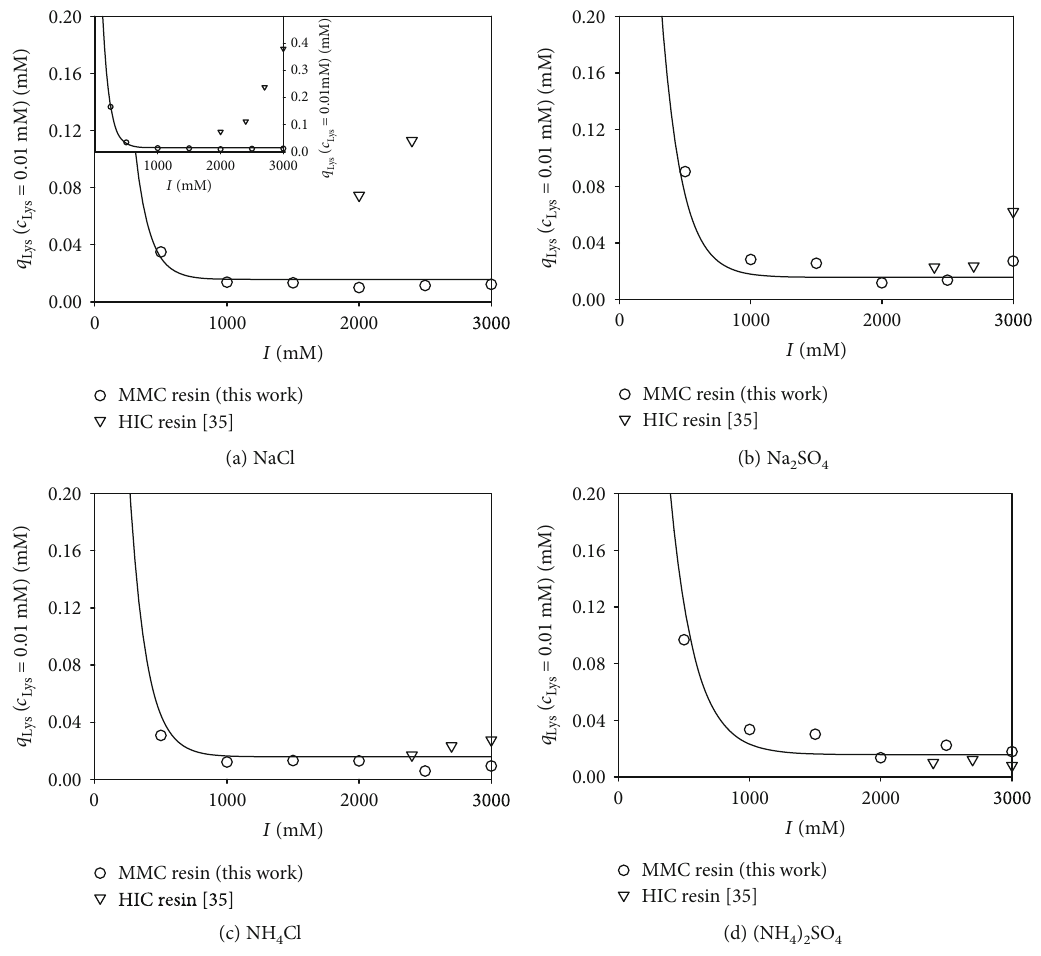
Figure 4: Lysozyme loading q Lys of the MMC resin Toyopearl MX-Trp-650M and the single-mode HIC resin Toyopearl PPG-600M at c = 0 : 01 mM, pH 7.0, and 25 ° C for all studied salts as a function of ionic strength I . Symbols: experimental results. Lines: correlations of Lys the MMC results with Equation (2). In order to display all experimental HIC data for sodium chloride, an additional inset fi gure with a larger scale is